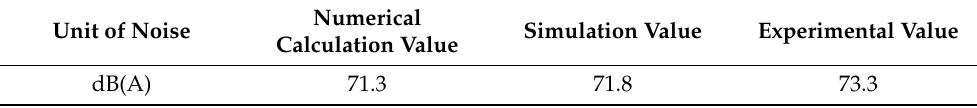
Table 3. Comparison of numerical calculation, simulation, and experimental